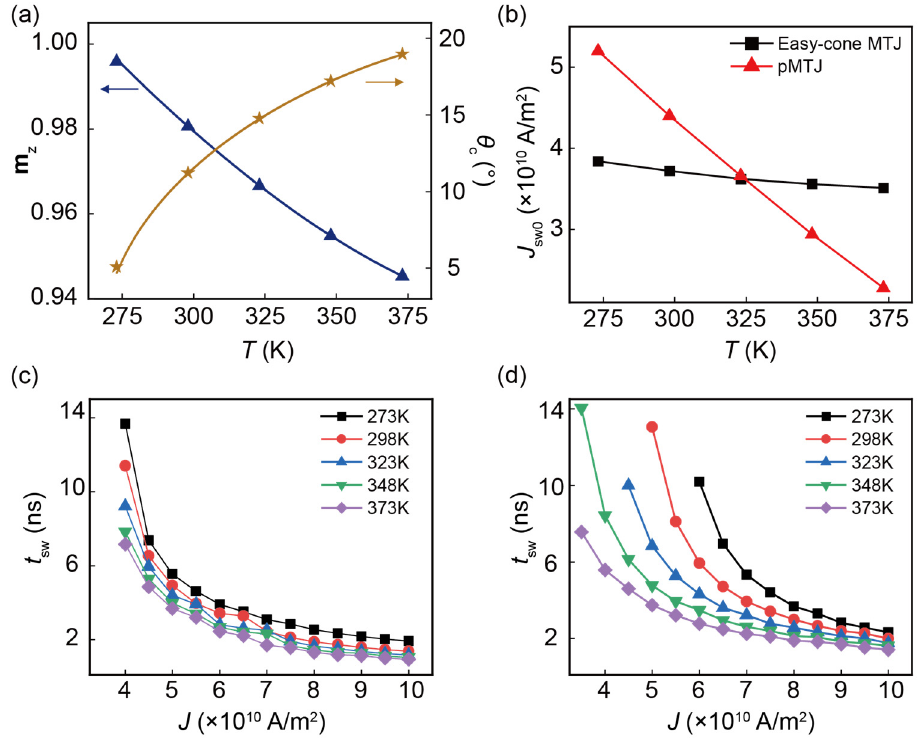
Figure 3. ( a ) The equilibrium m z and initial polar angle θ c as a function of temperature. ( b ) Temperature dependence of the intrinsic switching current density J sw0 in the easy-cone MTJ and pMTJ. Switching delay t sw as a function of current density in the ( c ) easy-cone MTJ and ( d ) pMTJ. T = 273 K, 298 K, 323 K, 348 K, and 373 K are represented by square, circle, triangle, down-pointing triangle, and rhombus, respectively.